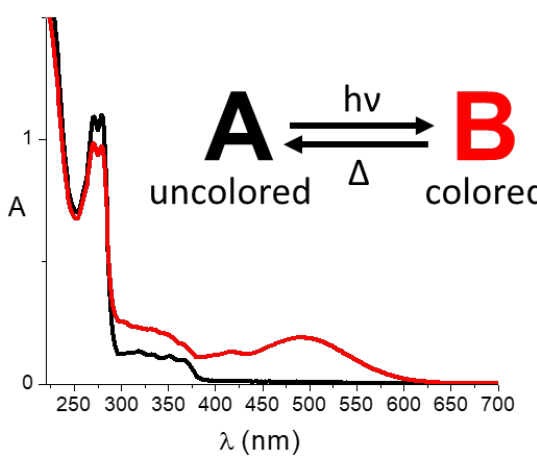
Figure 8. Example of a direct thermally reversible photochromic compound.